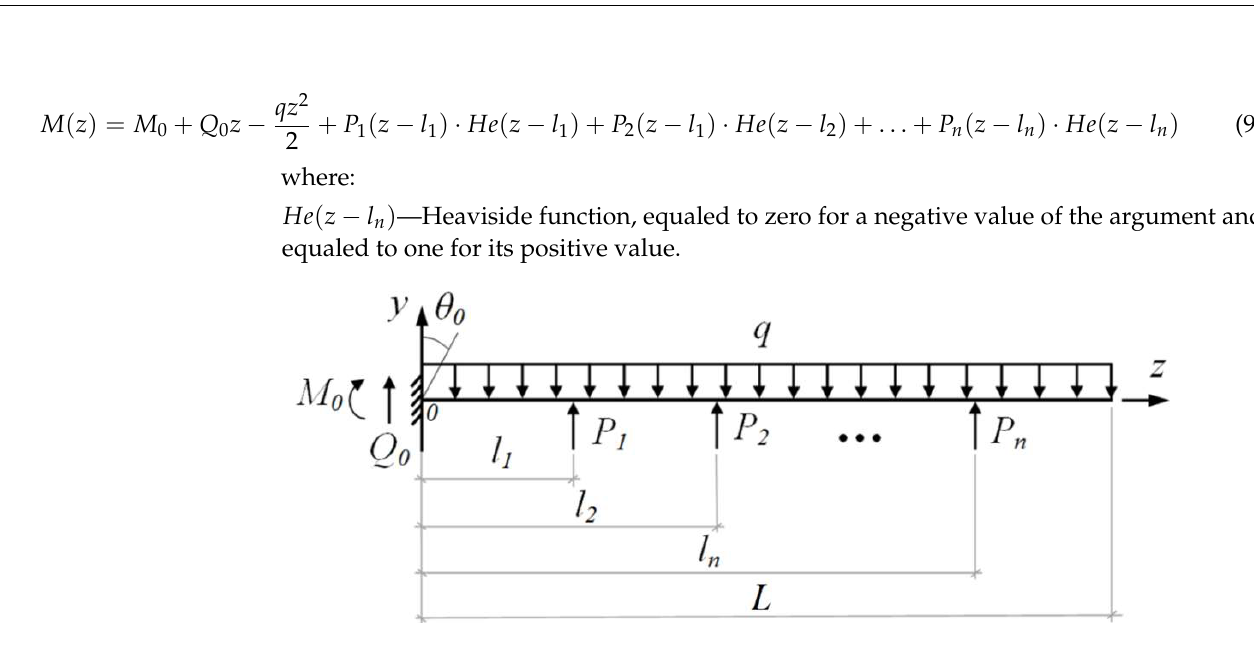
Figure 10. Calculation scheme for calculating the forces for centering the ends of the pipeline: P 1 , P 2 , P n —forces applied by hydraulic cylinders, N; Q 0 —transverse force in the place of the fixed support, N; M 0 —bending moment in the place of the fixed support, N ·